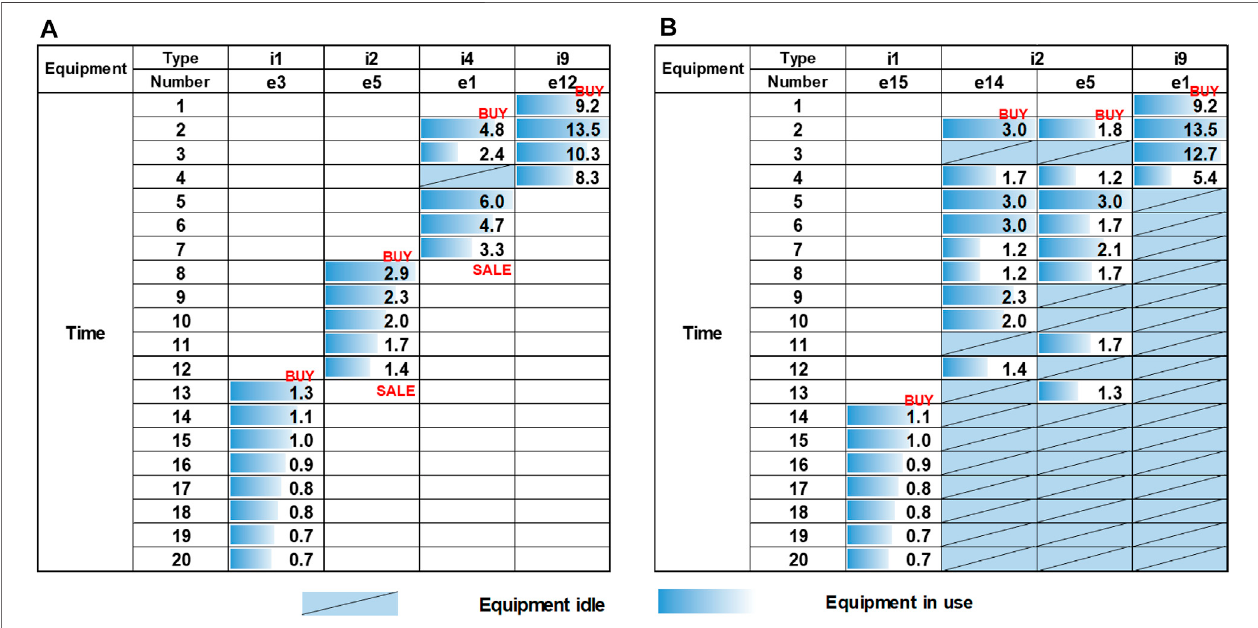
FIGURE 4 | The selection and usage of equipment in the whole time period. (A) Modular equipment and (B) traditional equipment.